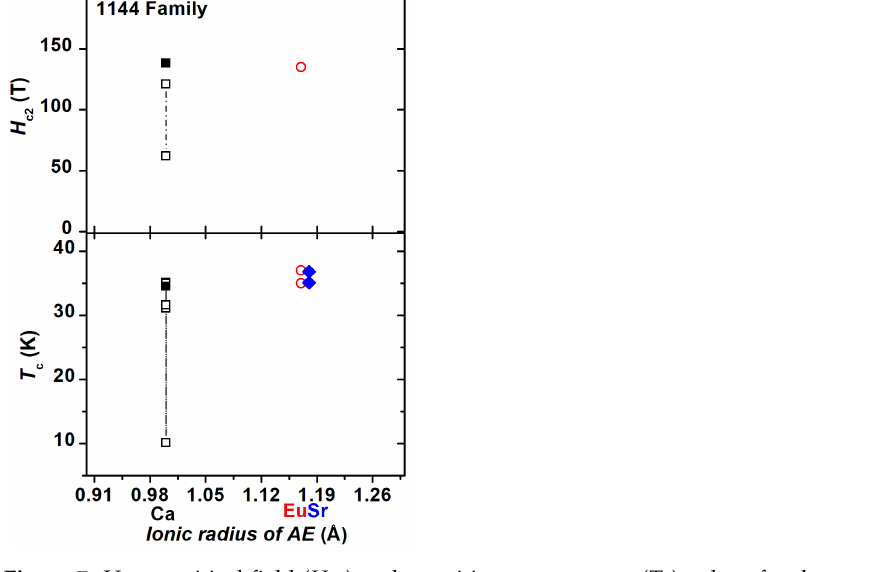
Figure 7. Upper critical field ( H c2 ) and transition temperature ( T c ) values for the reported single crystal and polycrystalline 1144 ( AEA Fe 4 As 4 ; AE = Ca, Eu, Sr) family with respect to the ionic radius of AE are shown. The data have been taken from Tables 1 and 2.